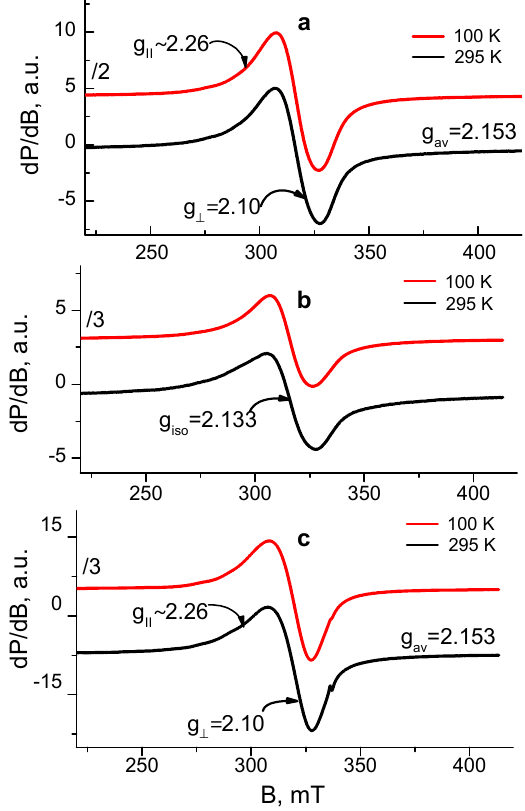
Figure 7. EPR spectra at 100 and 295 K of ( a ) Cu 2+ -Ch-8Q/PLA mat, ( b ) Cu 2+ -Ch/PLA mat and ( c ) Cu 2+ -Ch-8Q in the solid state.